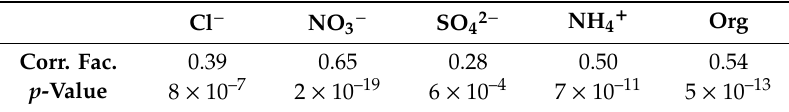
Table 1. Pearson’s correlation coe ffi cients and corresponding p -values between PM-bound ROS and major TOF-ACSM fragments over the shown measurement period ( n = 141), being chloride (Cl − ), nitrate (NO 3 − ), sulphate (SO 42 − ), ammonium (NH 4 + ) and total organics (Org). PM-bound ROS was found to correlate best with nitrate. + Org Cl − NO 3 − SO 42 − NH 4 Corr. Fac. 0.39 0.65